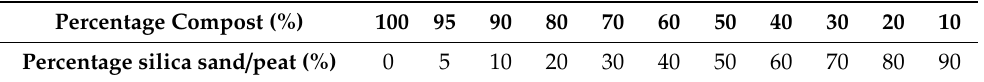
Table 1. Mixing ratios of soil substrates for water holding capacity (WHC) tests. Percentage is based on the oven-dried mass.